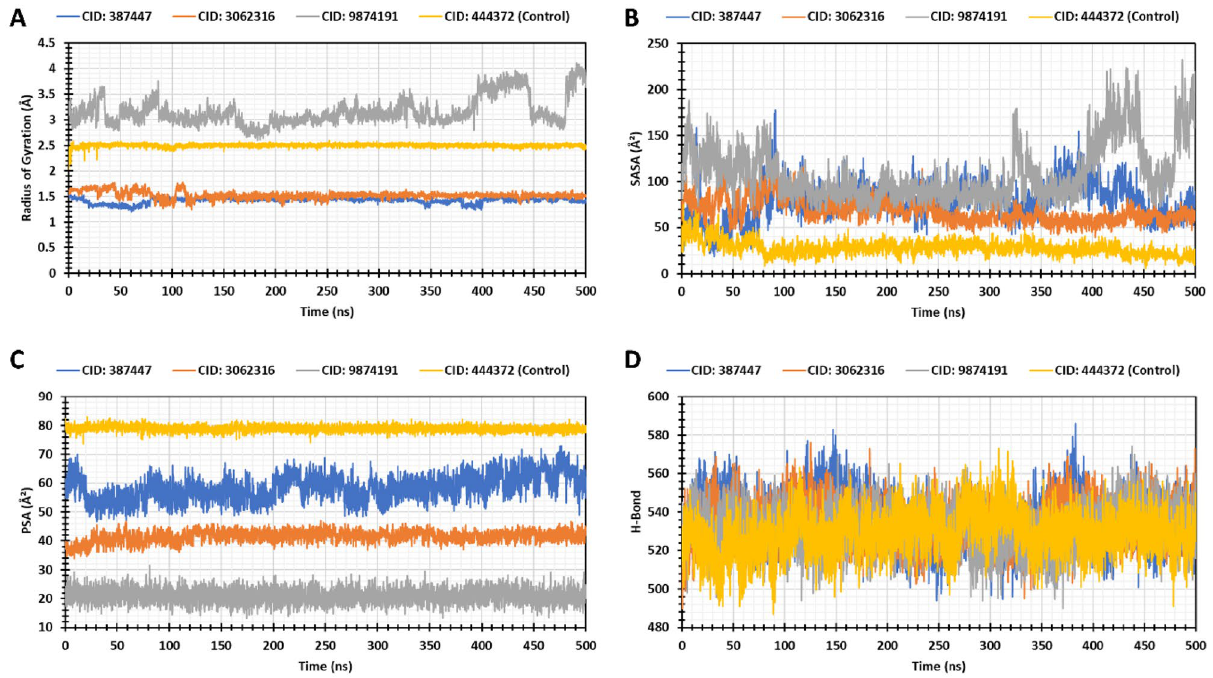
Figure 8. Graphs represent the MD simulation result by 500 ns time. Here, ( A ) exhibited the result of the radius of gyration (Rg) values of MCM7 protein, ( B ) denote the values of SASA, ( C ) PSA, and ( D ) Hydrogen